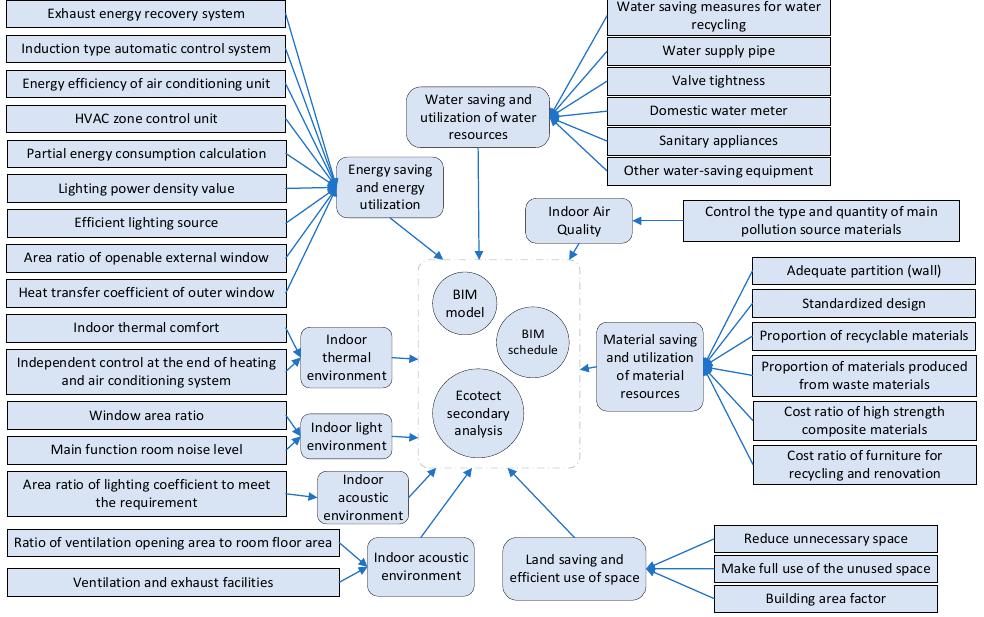
Figure 2. Green evaluation index system of building interior decoration based on BIM.